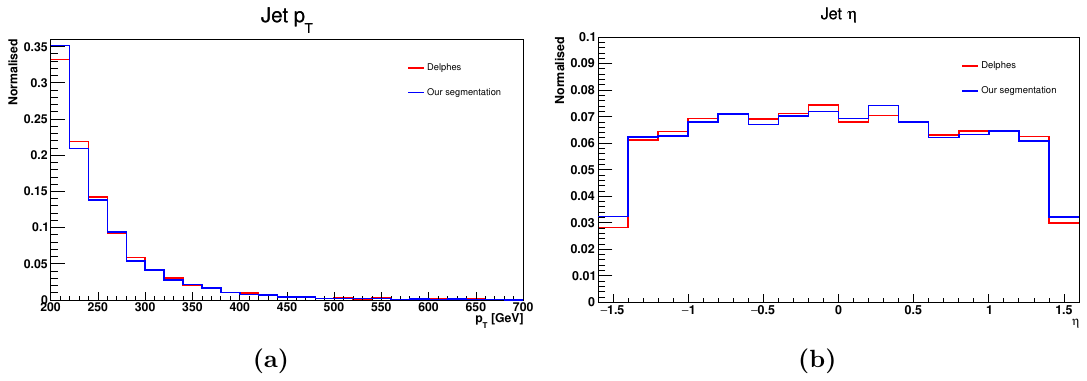
Figure 14. Comparison of (a) p T and (b) (cid:17) distributions using Delphes and our simulation for the leading jet (prompt) from a dijet sample generated with minimum p T cut of 200